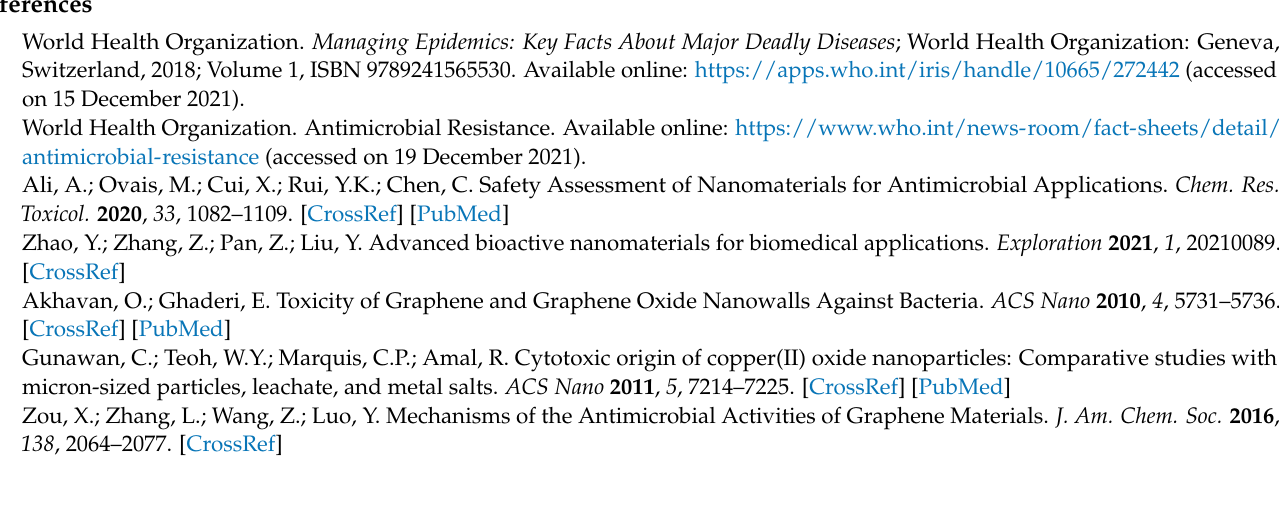
different concentrations; Figure S2. Optical properties of Magnetic Nanocomposites: (a) UV-VIS spectra of VCL/PEGDA (3mL) with different concentrations of MNPs-GO, (b) UV-VIS spectra of VCL/PEGDA (3mL) with MNPs-GO-ZnMintPc at different concentrations; Figure S3. (a) Composites calibration curve of ZnMintPc (0.52 µ M) from: PS in DMF, VCL/PEGDA, VCL/PEGDA-MNPs- GO and VCL/PEGDA-MNPs-MWCNTs; (b) Absorbance of ZnMintPc-DMF and nanocomposites; Figure S4. Photodynamic Analyses of: (a) UV-VIS spectra of VCL/PEGDA-MNPs-GO and (b) UV-VIS spectra of VCL/PEGDA-MNPs-MWCNTs; Figure S5. Photodynamic Analyses of: (a) UV-VIS spectra of VCL/PEGDA-MNPs-GO-ZnMintPc and (b) UV-VIS spectra of VCL/PEGDA-MNPs-MWCNTs- ZnMintPc; Figure S6: (a) SEM analysis, (b) TEM analysis, (c) Atomic force microscopy (AFM) image (d)Height profile along the line of the panel from GO (e) EDS analysis and (f) XRD of GO; Figure S7. (a) SEM, (b) TEM, (c) EDS and (d) XRD analysis of MWCNTs; Figure S8. (a) SEM, (b) TEM, (c) EDS and (d) XRD analysis of MNPs; Figure S9. (a) SEM, (b) TEM, (c) EDS and (d) XRD analysis of MNPs-GO; Figure S10. (a) SEM, (b) TEM, (c) EDS and (d) XRD analysis of MNPs-MWCNTs; Figure S11: (a) SEM, (b) TEM, (c) EDS analysis of VCL/PEGDA-MNPs-GO; Figure S12: (a) SEM, (b) TEM, (c) EDS analysis of VCL/PEGDA-MNPs-MWCNTs; Figure S13. (a) SEM, (b) TEM, (c) EDS and (d) XRD analysis